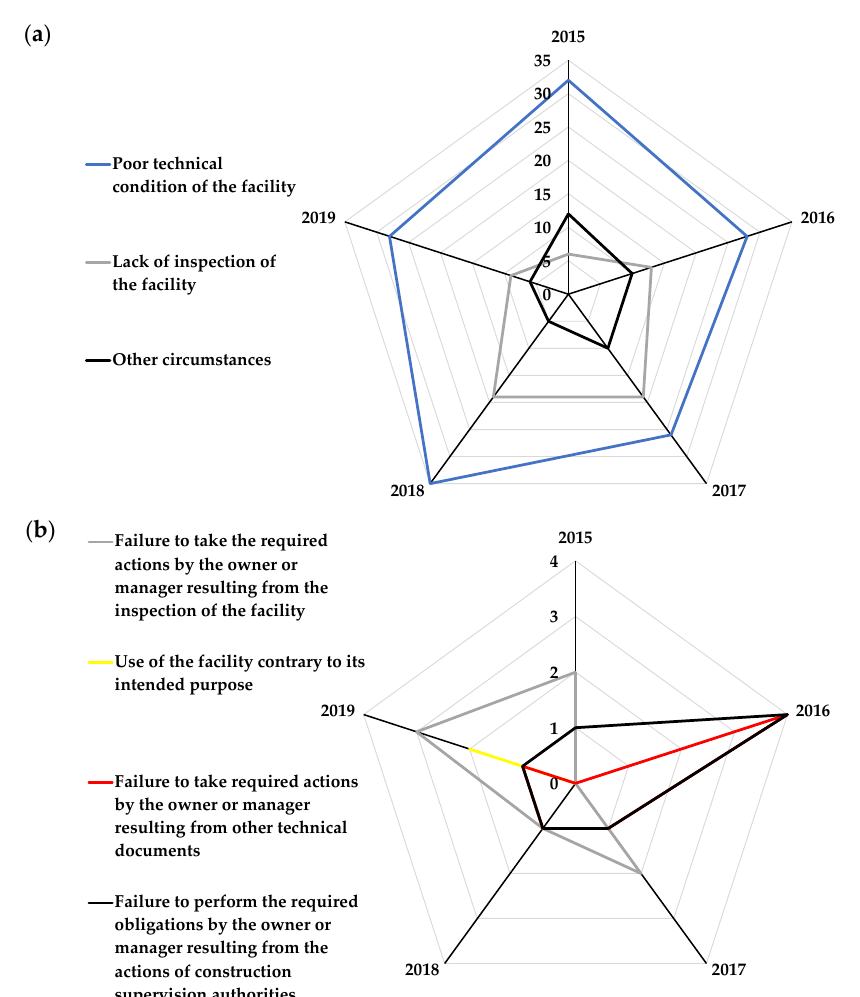
Figure 7. Causes of the structural failures occurring during maintenance of the facility ( a ) part 1; ( b ) part 2 (own study). ( b ) part 2 (own study).